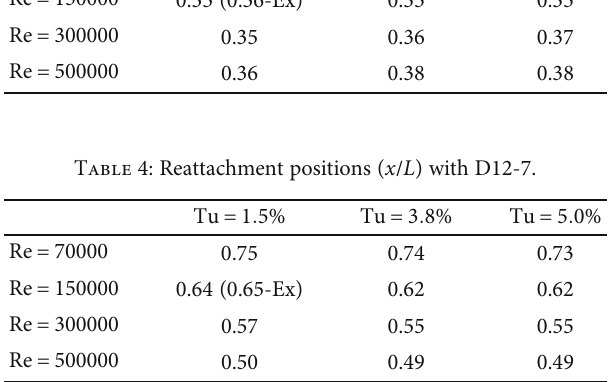
Table 5: Maximum H